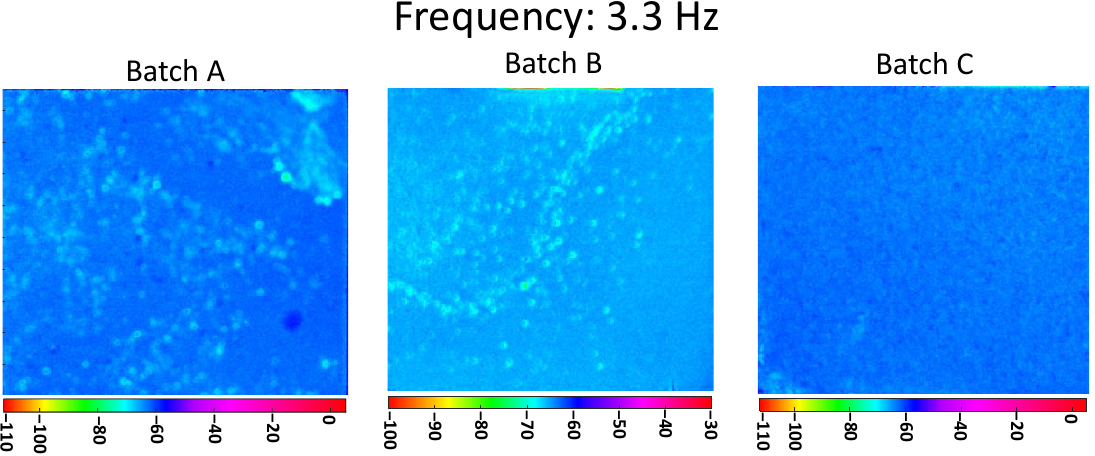
Figure 5. PPT phasegrams of a sample of each batch computed at the selected frequency 3.3